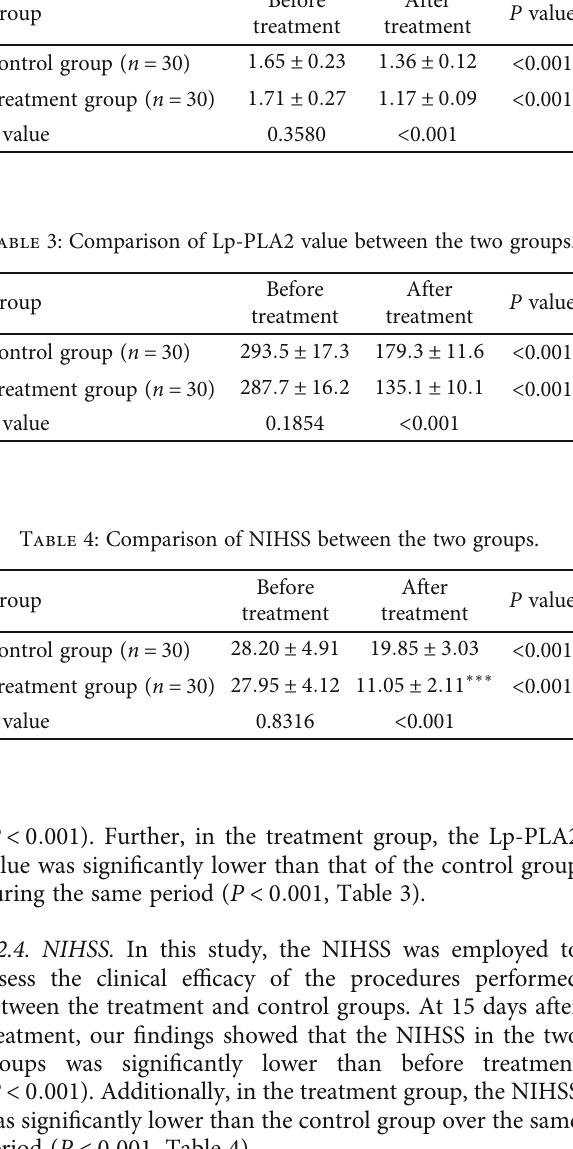
Before After P value treatment treatment